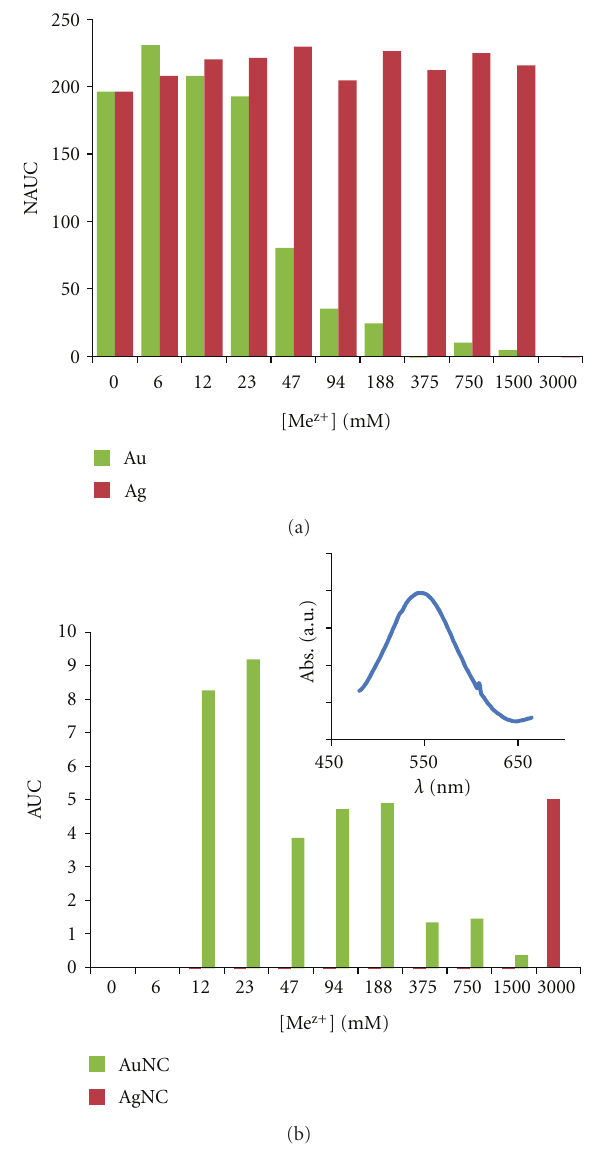
Figure 1: Influence of silver and gold concentration on (a) yeast growth and (b) in uninoculated growth medium (glucose). Measurements were performed at OD 610 nm and NAUC (net area under curve) values refer to 6 days. Inset: UV-Vis spectra recorded after the reaction of uninoculated growth medium with 1mM HAuCl 4 for 24 h.